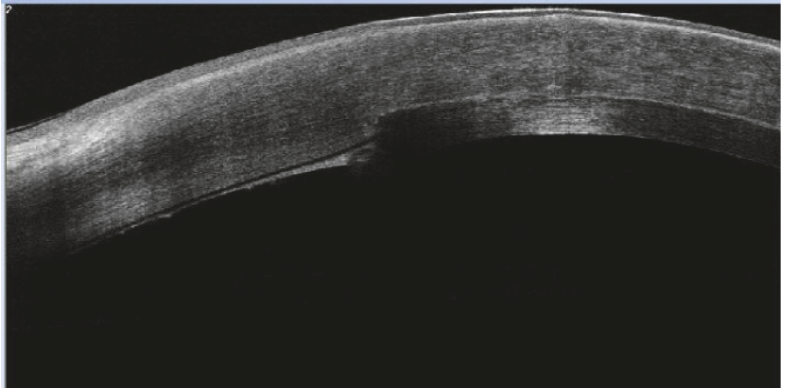
Figure 11: Much better match one month postoperatively after parameter modi fi cation.